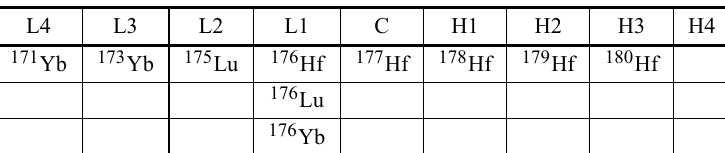
Neptune Faraday cup configuration for Lu-Hf